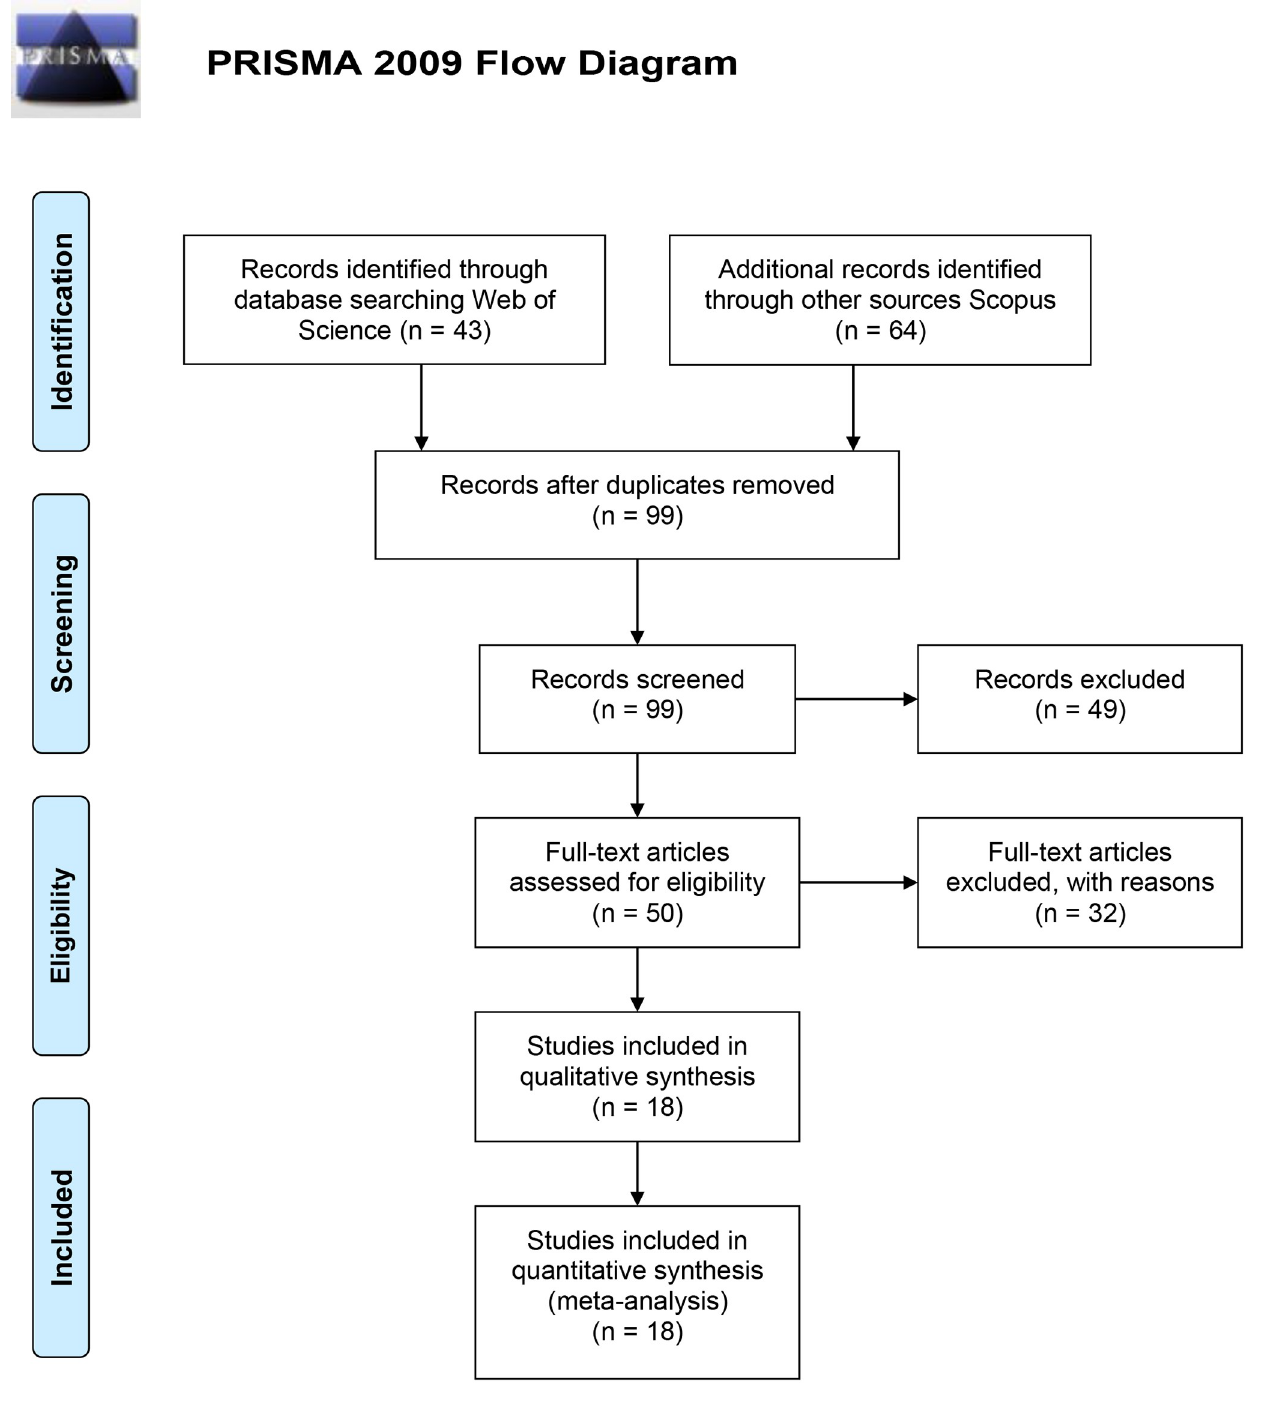
Fig 1. Flowchart of the literature search.